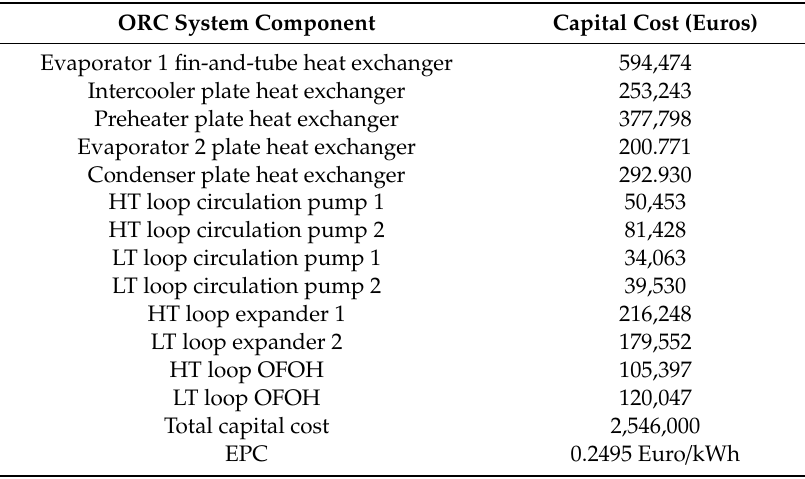
Table 9. Capital costs of regenerative dual-loop ORC system